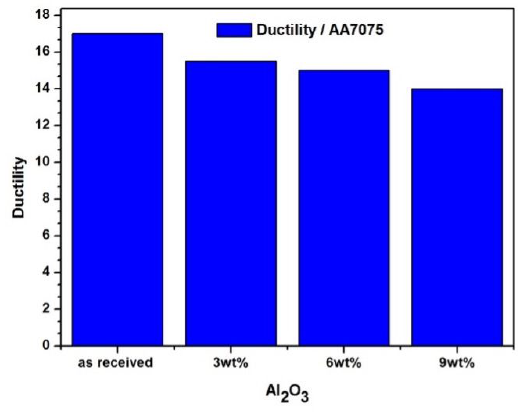
Figure 7: The variation of ductility with Al 2 O 3 wt% in comparison with the